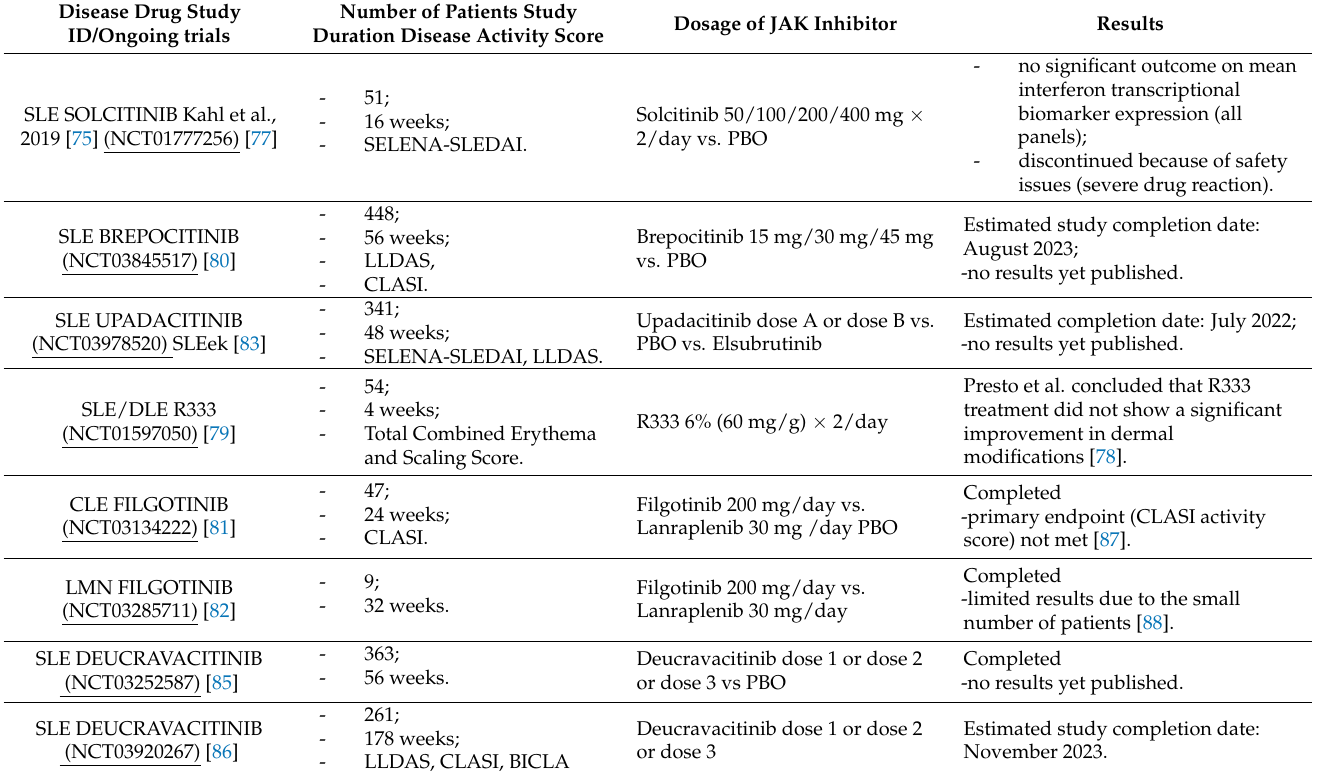
Table 5. New JAK inhibitors for SLE patients and the main results of clinical trials. Disease Drug Study Number of Patients Study Dosage of JAK Inhibitor ID/Ongoing trials Duration Disease Activity Score